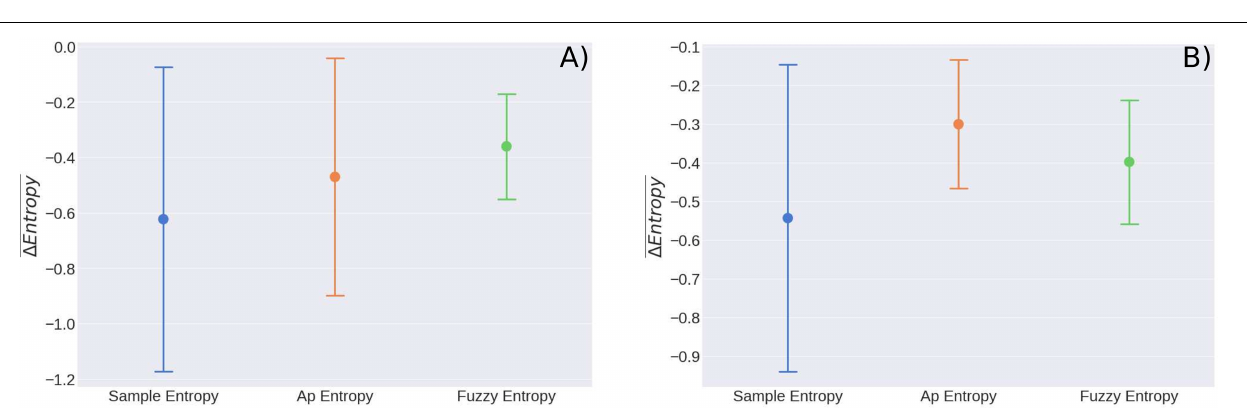
FIGURE 5 | SampEn values for rest and cardiac stress tests for (A) 25 young subjects and (B) six middle aged adults. The speeds for the stress tests were 4 mph and 3.5 mph, respectively. There are no significant statistical differences.